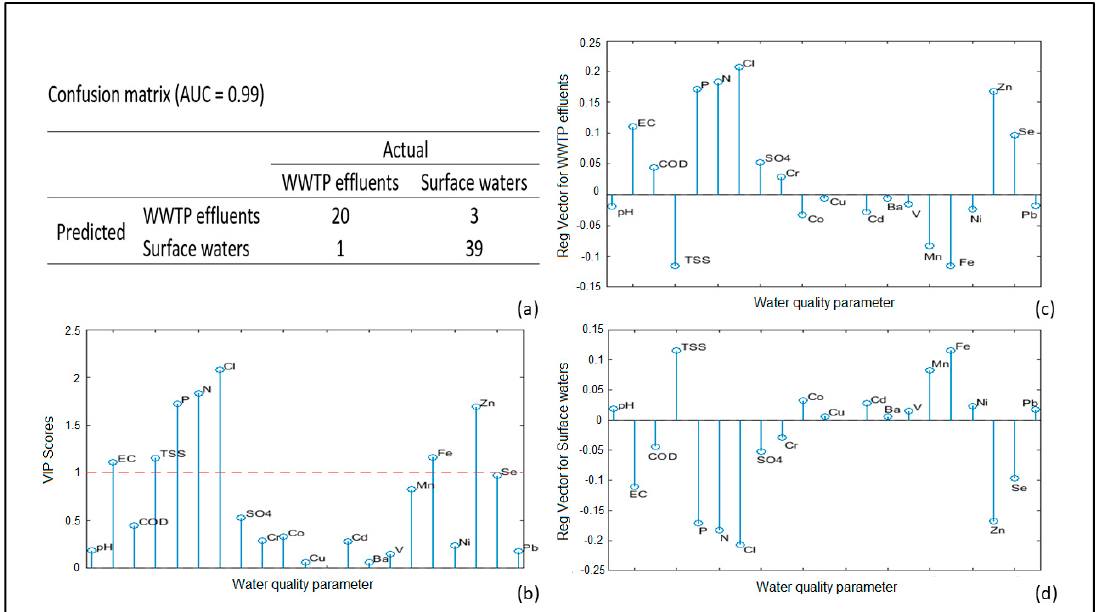
Figure 2. The partial least squares–discriminant analysis (PLS-DA) model results for WWTP effluents and surface waters based on physicochemical water quality parameters: ( a ) Confusion matrix; ( b ) VIP (variable importance on projection) scores; ( c ) Regression vector for WWTP effluents; ( d ) Regression vector for surface waters.